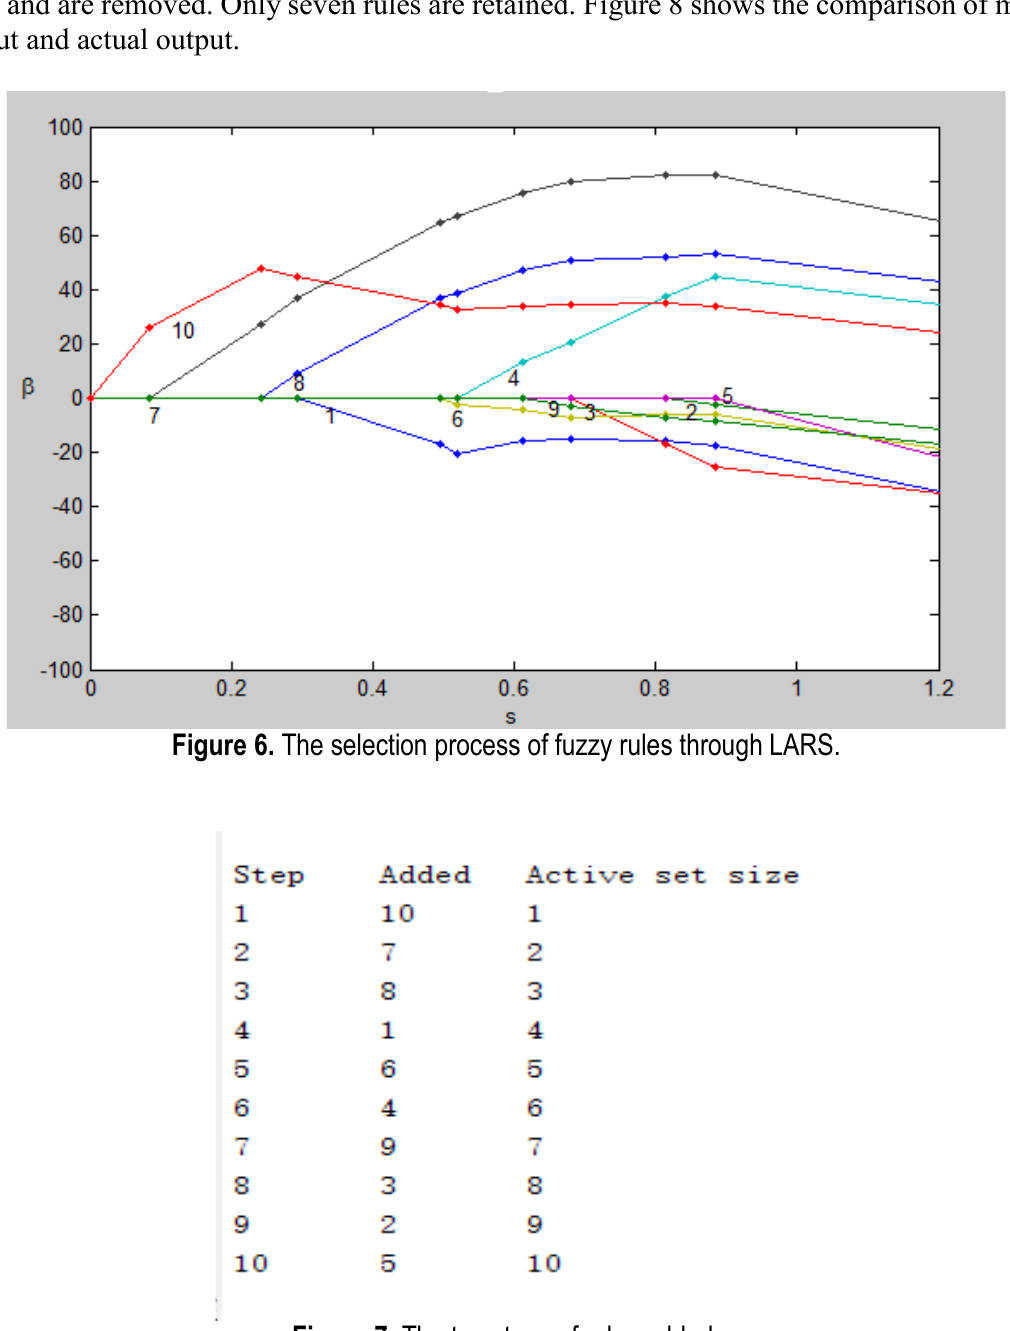
Figure 7. The ten steps of rules